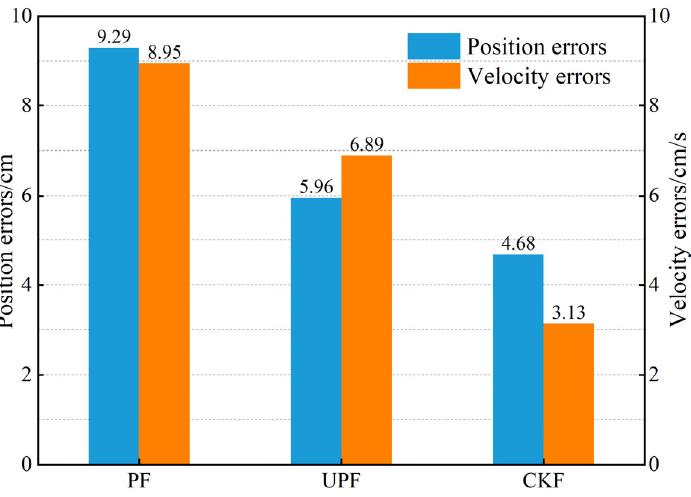
Figure 6. The results of the filtering experiment.